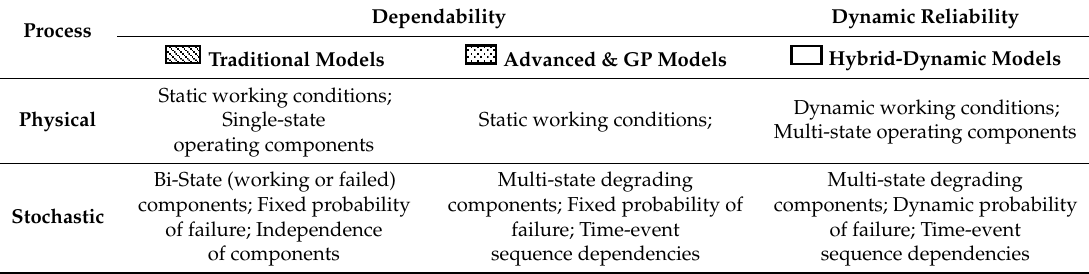
Figure 1. Breakdown of the categories of stochastic modelling methods for the dependability assessment. Table 1. Main characteristics of the stochastic models used in dependability assessment.